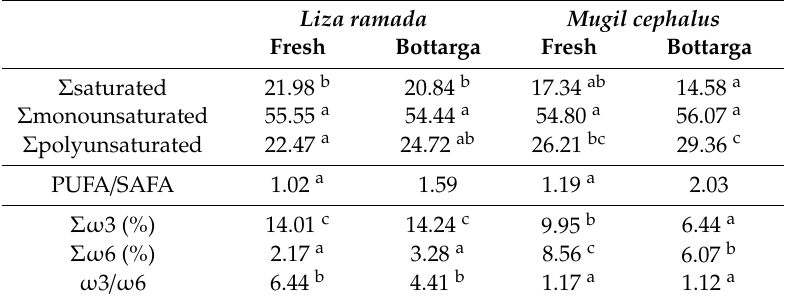
Table 6. Fatty acid composition (%) of fresh roe and bottarga of M. cephalus and L. ramada collected from Sardinia